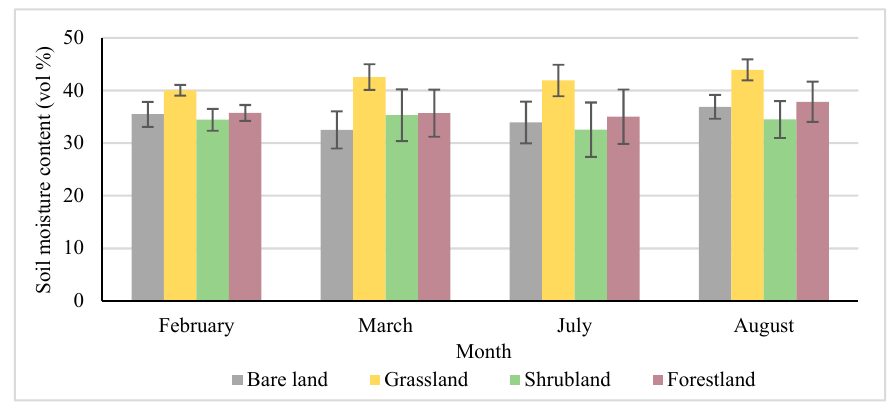
Figure 5. Average volumetric soil moisture content and temporal variations with respect to different vegetation types in February, March, July, and August. Table 4. Meteorological data from February, March, July, and August.